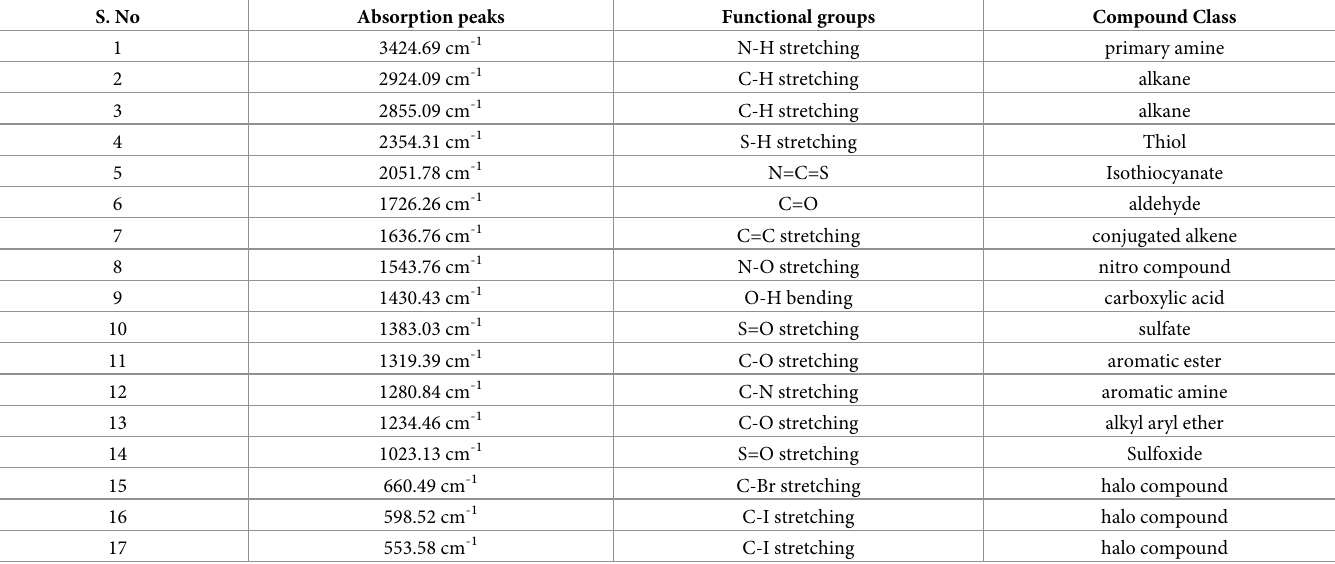
Table 1. Functional groups corresponding to different absorption peaks obtained for the AgNPs.